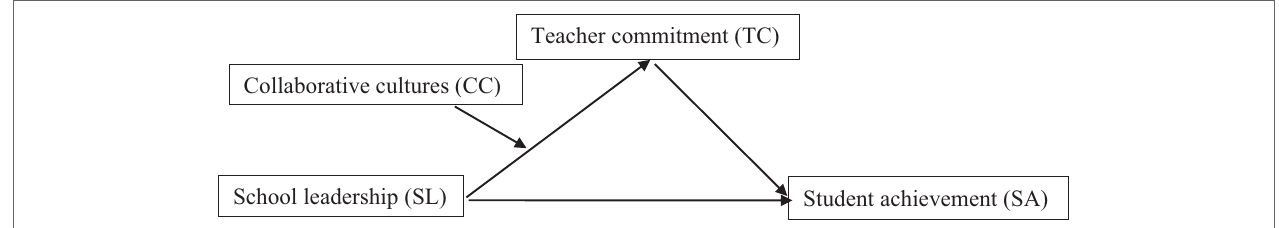
FIGURE 1 | Proposed moderated mediation model linking SL to SA in rural Chinese